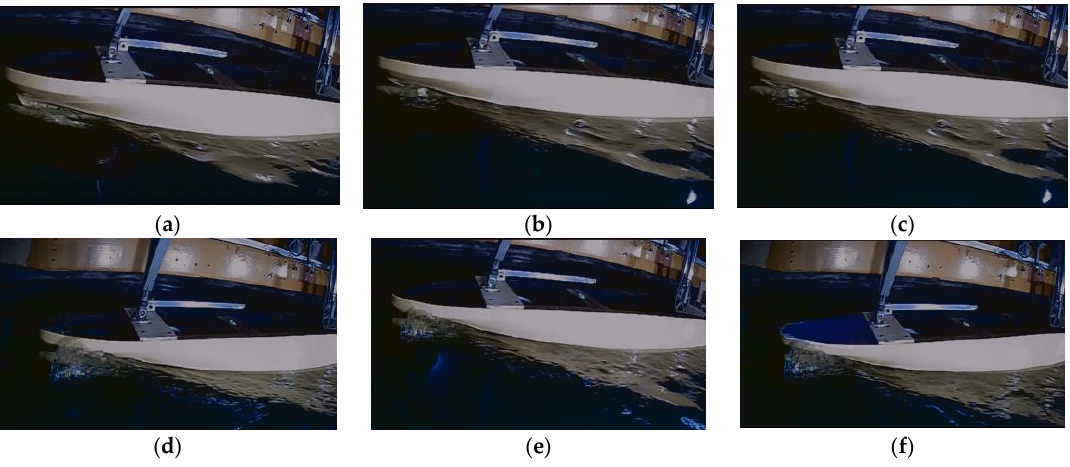
Figure 10. Flow around hull for the following cases: ( a ) λ w / L PP = 0.875 for 𝐹 𝑅 = 0.131 and H w = 0.03 m; ( b ) λ w / L PP = 1.000 for 𝐹 𝑅 = 0.131 and H w = 0.03 m; ( c ) λ w / L PP = 1.125 for 𝐹 𝑅 = 0.131 and H w = 0.03 m; ( b ) λ w / L PP = 1.000 for F R = 0.131 and H w = 0.03 m; ( c ) λ w / L PP = 1.125 for F R = 0.131 and H w = 0.03 m; ( d ) λ w / L PP = 0.875 for 𝐹 𝑅 = 0.131 and H w = 0.057 m; ( e ) λ w / L PP = 1.000 for 𝐹 𝑅 = 0.131 and H w = 0.057 m; ( d ) λ w / L PP = 0.875 for F R = 0.131 and H w = 0.057 m; ( e ) λ w / L PP = 1.000 for F R = 0.131 and H w = 0.057 m; ( f ) λ w / L PP = 1.125 for 0.664 m/s and H w = 0.057 m. ( f ) λ w / L PP = 1.125 for 0.664 m/s and H w = 0.057